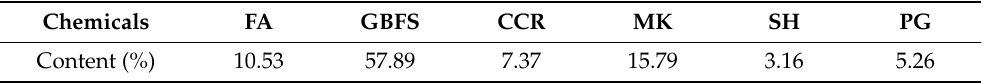
Table 1. Content of chemicals used for industrial waste-based binder